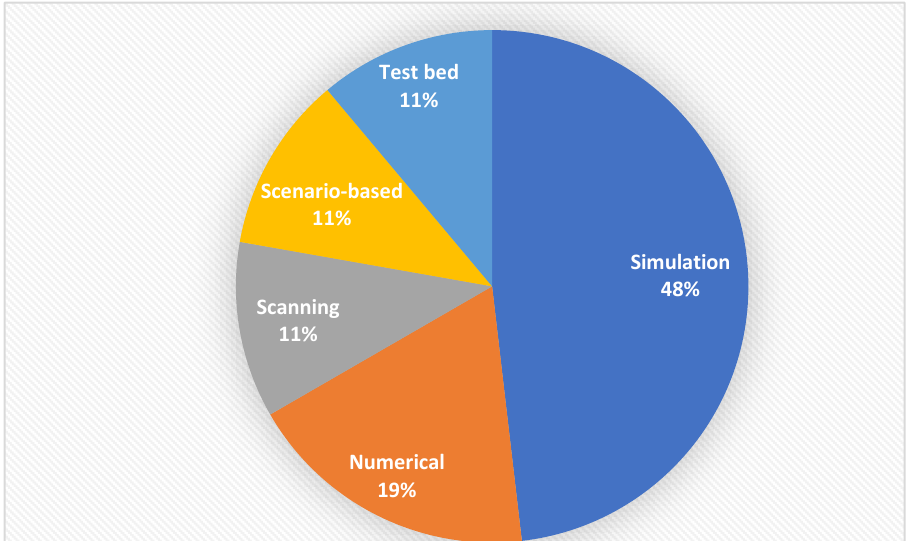
Figure 12. Validation methods for IoT vulnerability assessment approaches.